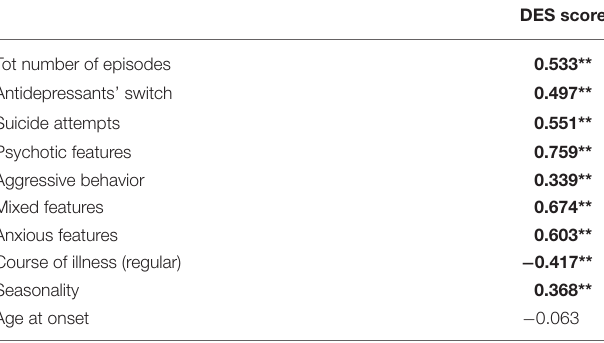
TABLE 2 | Spearman’s correlations between DES-II and clinical features.